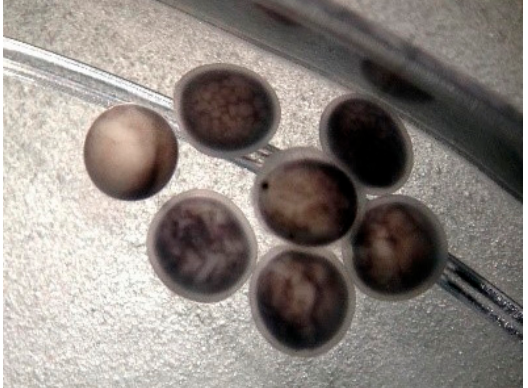
Figure 4. First stages of cleavage, 12 h after artificial insemination of sterlet eggs with cryopreserved Russian sturgeon semen: fertilized eggs with normal development, fertilized eggs with blastomere inhibition and unfertilized eggs.